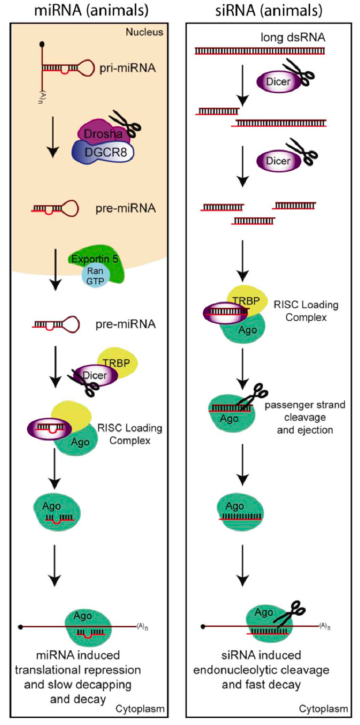
Figure 4. Major pathways for small RNA biogenesis and function. The major classes of RNAs involved in the endogenous RNAi response and that have been implicated in anti-viral function are microRNAs (miRNAs), and short-interfering RNAs (siRNAs), which are partially defined by their mechanisms of biogenesis and function. MiRNAs are typically derived from long Pol II transcripts, which fold into short imperfectly-basepaired hairpin structures. They undergo two cleavage steps by RNaseIII enzymes, Drosha in the nucleus and Dicer in the cytoplasm, to become ~22 nt dsRNAs. SiRNAs are normally derived from long perfectly-basepaired dsRNAs, which may result from convergent transcription, transcription of long inverted repeats, or by RNA dependent RNA Polymerases. Viruses often form dsRNA intermediates during their lifecycle. 22 bp products are produced by Dicer cleavage. SiRNAs are fairly uncommon in vertebrates; however, mammalian germ cells and embryonic stem cells appear to produce a variety of siRNAs from endogenous dsRNAs and long dsRNA [72–74]. One strand of the dsRNA is then incorporated into the RNA induced silencing complex (RISC) and becomes known as the miRNA or siRNA guide strand. A principal component of the RISC complex is an Argonaute (AGO) family protein which goes on to sequence-specifically recognize target mRNAs. MiRNAs typically show imperfect complementarity to their target sequences and therefore direct translational repression and a slow decapping and decay of the target mRNA. SiRNAs are perfectly complementary to their target mRNAs. This perfect complementarity activates the endonuclease or “slicer” activity of Ago so that the target is cleaved and quickly